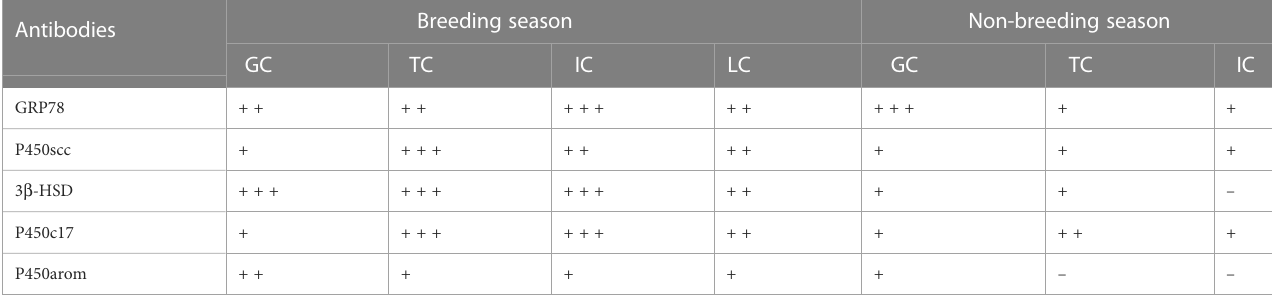
TABLE 2 Relative abundance of Bip/GRP78, ATF4, ATF6, XBP1s, P450scc, 3 b -HSD, P450c17, and P450arom in ovaries of the muskrats during the breeding and non-breeding seasons.